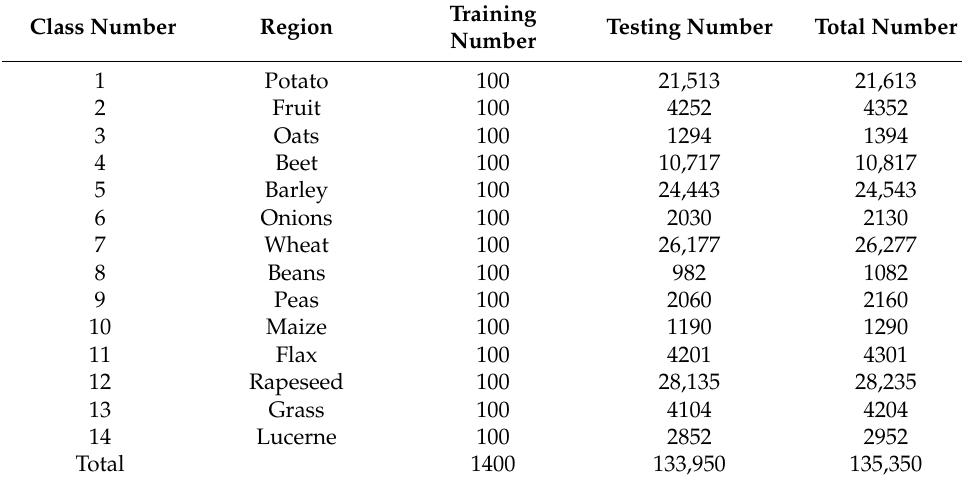
Table 2. Training and testing samples of the Flevoland-14 dataset.